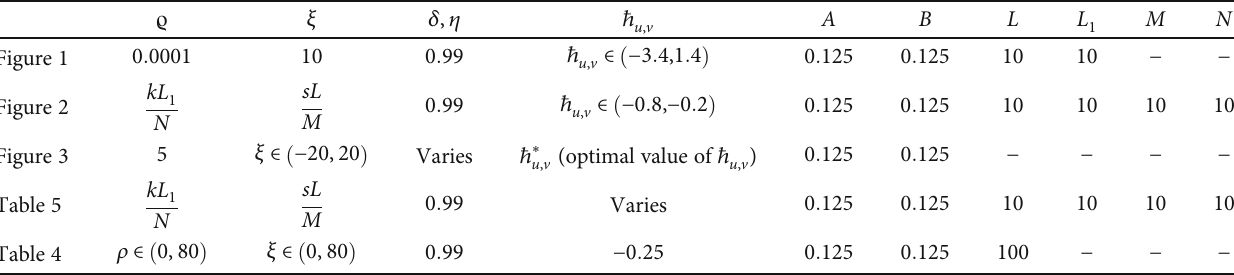
Figure 1: The ℏ u , v curves obtained from the 3rd order of the FHATM solutions using the ABC, CFC, and LC when ξ = 10 : Table 4: List of variables and parameters